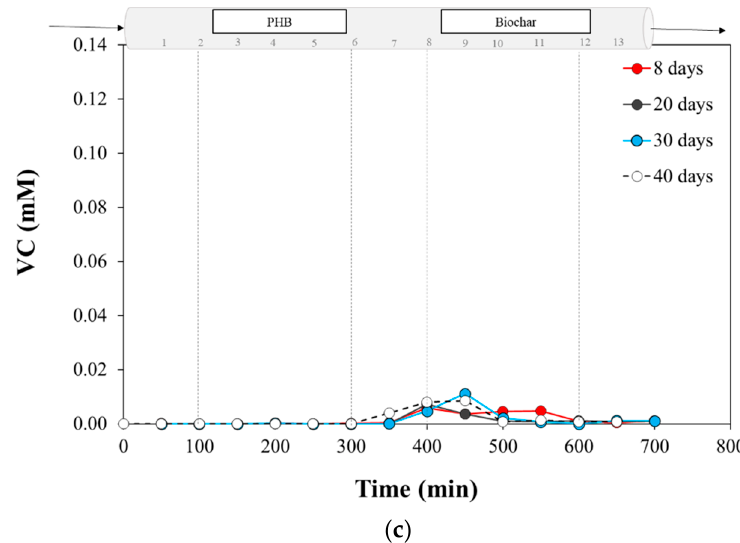
Figure 7. Axial profile as a function of time of ( a ) TCE; ( b ) cis-DCE and ( c ) VC at different operation days.